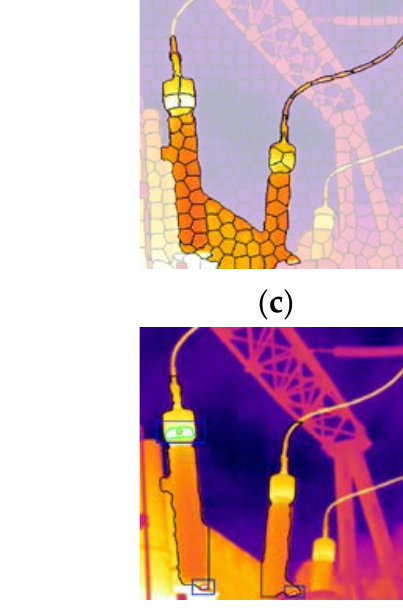
Figure 9. The results of each step in the process of diagnosis by Shao’ method ( a ) Super pixel segmentation ( b ) Image recognition ( c ) Super pixel binning ( d ) Image segmentation ( e ) Area to be inspected ( f ) Diagnosis result.